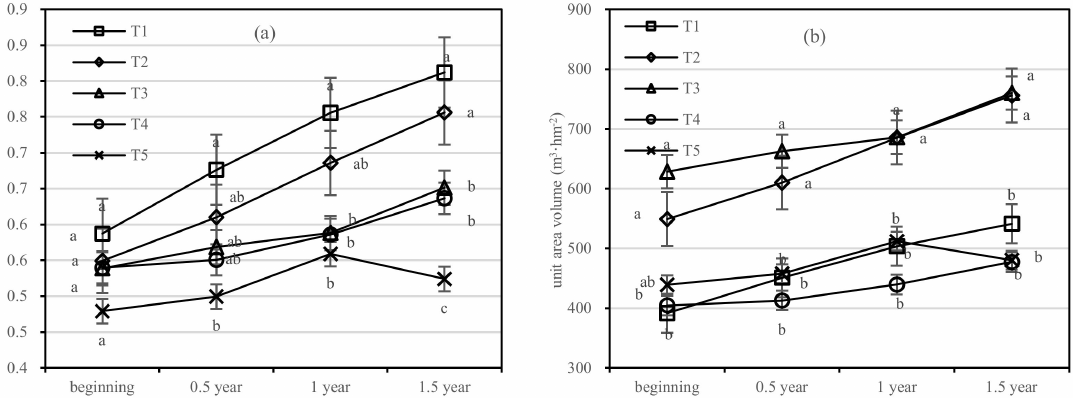
Figure 9. Individual volume and unit area volume of Pinus tabuliformis in four periods under five fertilization types. Data are the mean content ± standard deviation. Letters represent differences ( α = 0.05). T1: adjustment of C/N and C/P + 0.2% priming; T2: adjustment of C/N and C/P + 0.2% common compost; T3: adjustment of C/N and C/P; T4: raw material grinding of thinning shreds; T5: no fertilization. Additionally, ( a , b ) describe the individual volume and unit area volume,